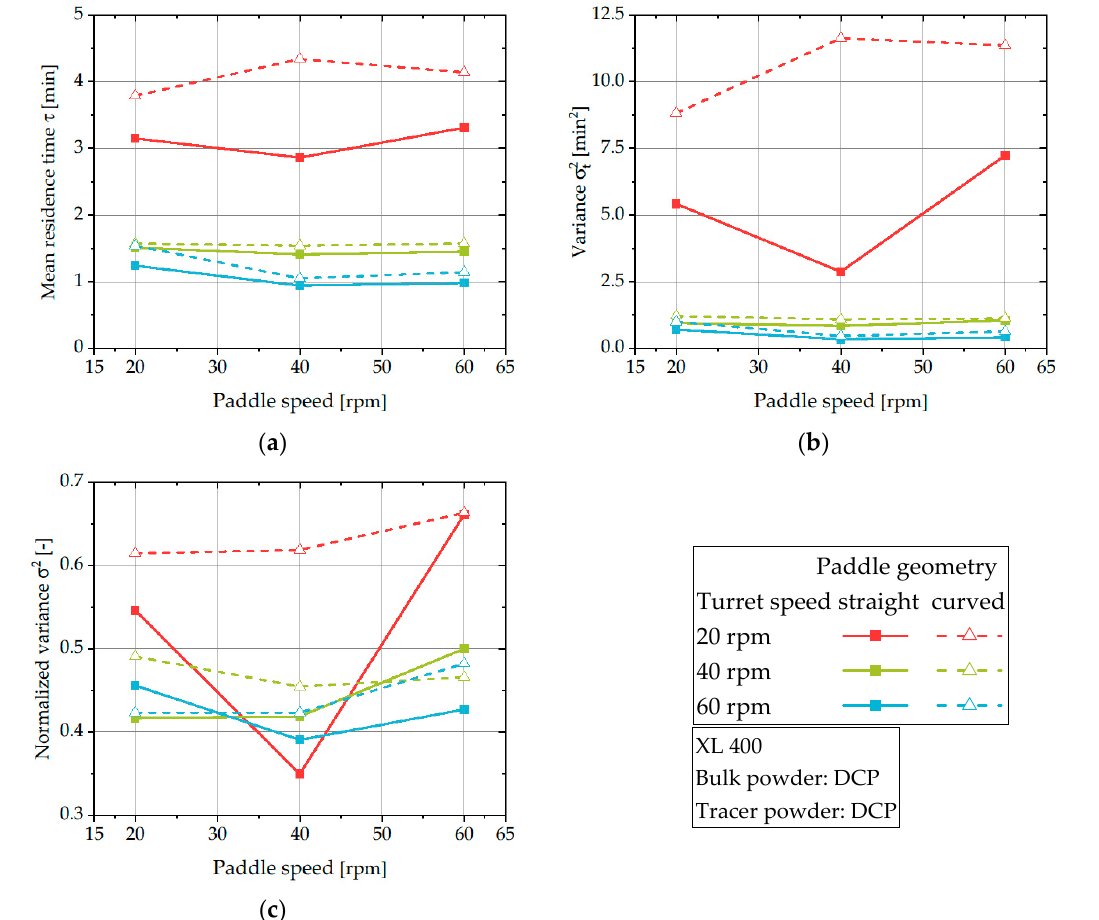
Figure 9. Mean residence time ( a ), variance ( b ), and normalized variance ( c ) of DCP for process parameters using the XL 400.